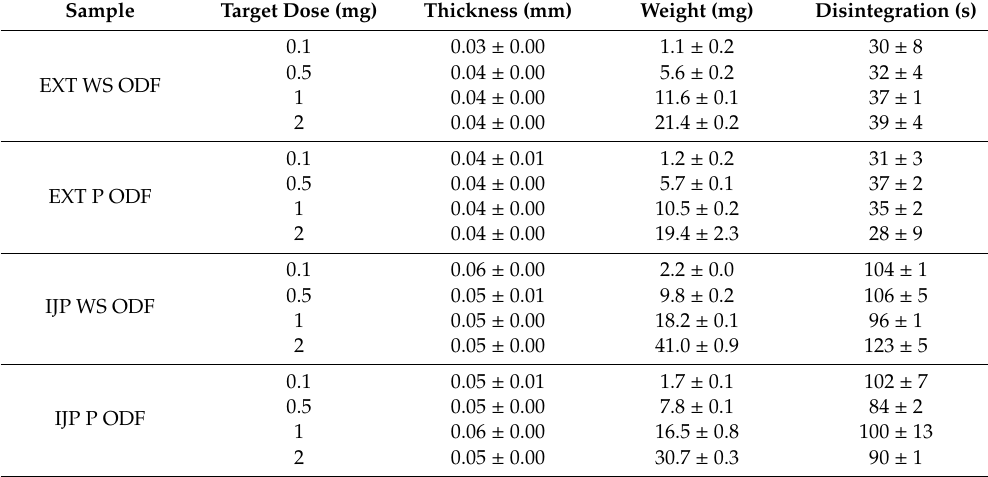
Table A3. Disintegration time of drug-loaded and placebo ODFs one day after